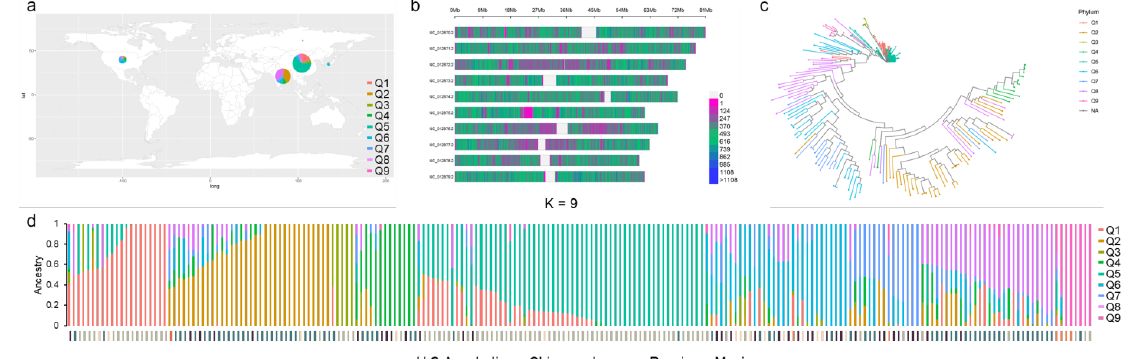
Figure 1. The analysis of population. ( a ) The distribution of all 214 landraces. ( b ) The density of SNPs in all chromosomes. ( c ) The neighbor − joining tree of all landraces. The colored subsections within each vertical bar indicate membership coefficient (Q) of the accession to different clusters. ( d ) The populations were pre − determined with K = 9 based on ADMIXTURE analysis. The bottom was the country of origin for each landrace. Different color indicates different membership coefficient (Q) in ( a , c , d ).